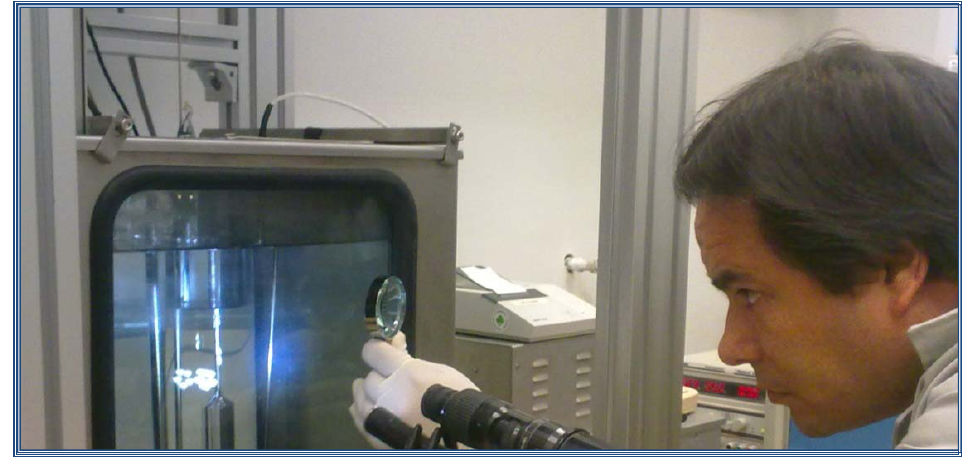
Figure 9. Traditional hydrometer calibration process.